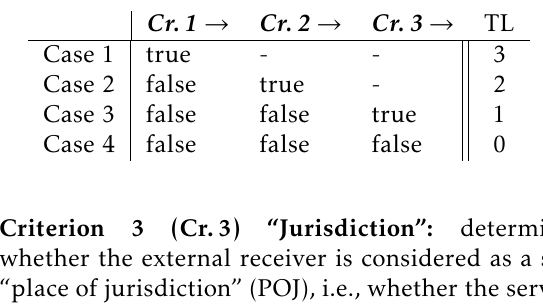
Table 1. Binary decision tree used for T L